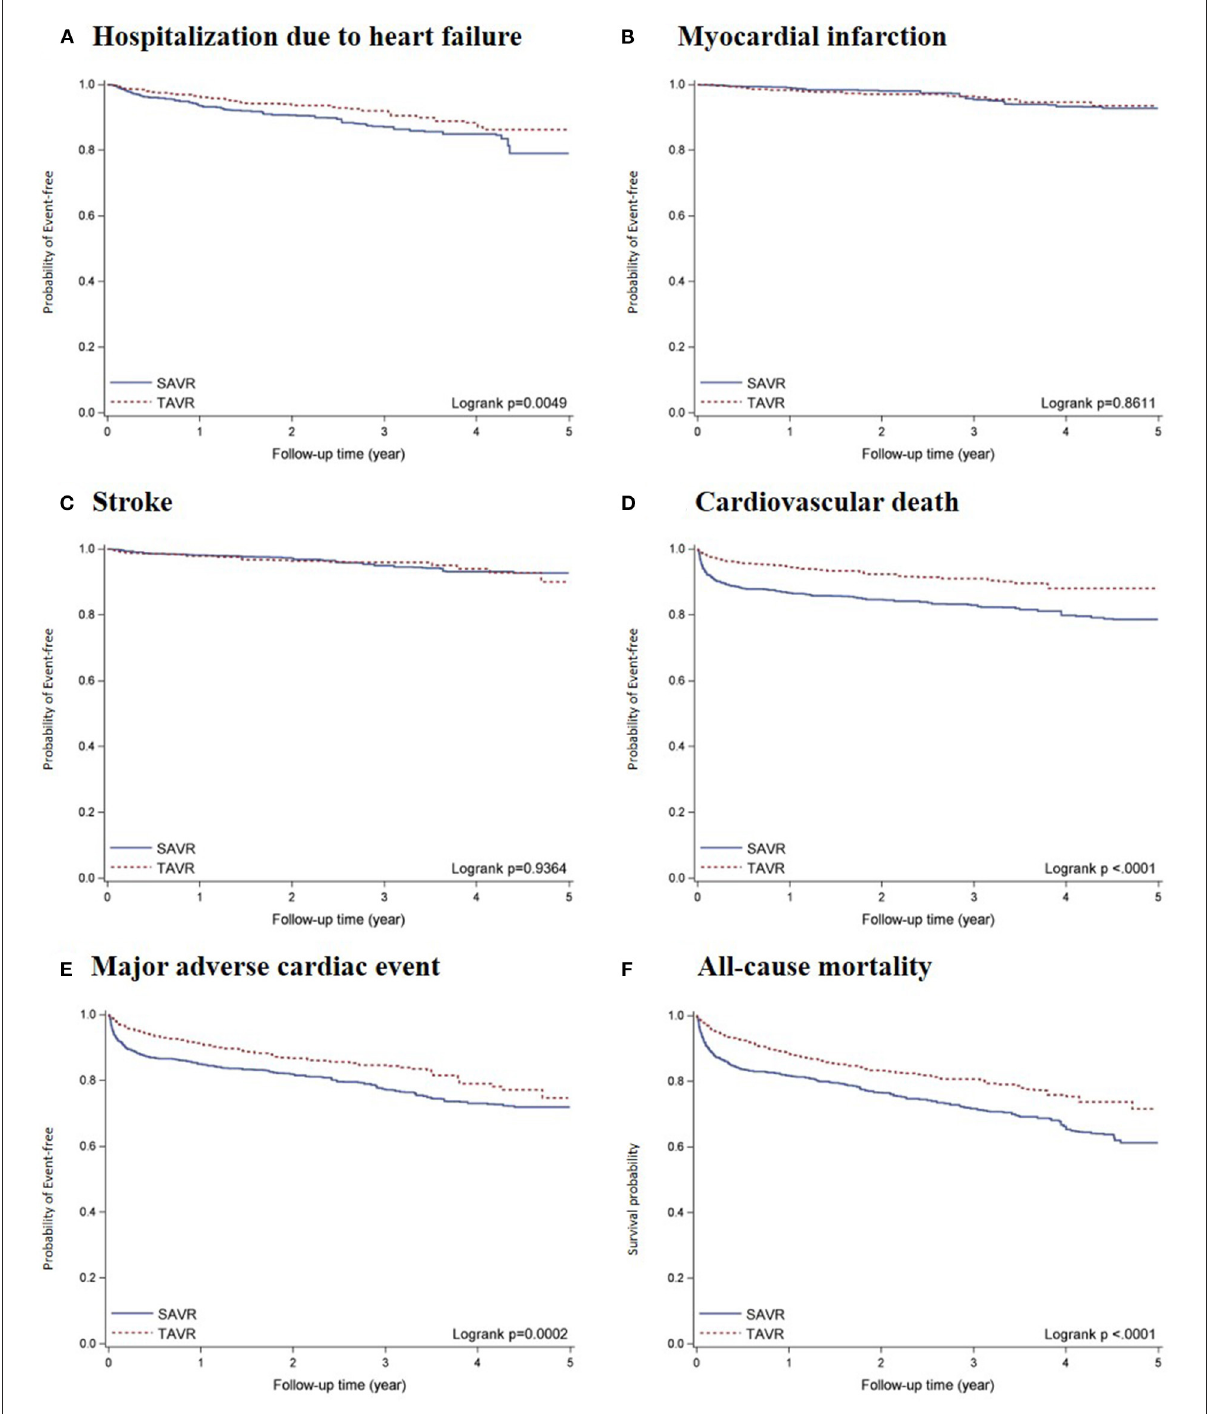
FIGURE2 Kaplan-Meier survival curves of all-cause mortality and incident CV-related outcomes comparing TAVR vs. SAVR after propensity score overlap weighting: (A) HHF; (B) MI; (C) Stroke; (D) CV death; (E) MACE; and (F) ACM. Results of Kaplan-Meier survival analysis of primary and secondary outcomes after propensity score overlap